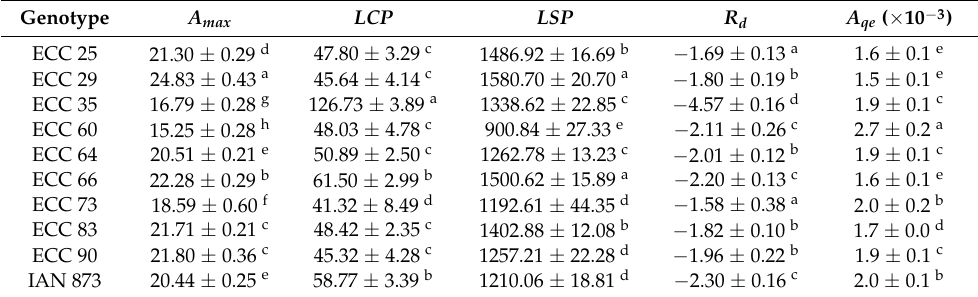
Table 1. Traits derived from the photosynthetic light-response curves ( A/PAR ) in nine Hevea brasiliensis genotypes from the ECC-1 ( É lite Caquet á Colombia) selection and the cultivar IAN 873 (control) in Caquet á (Northwestern Colombian Amazon). Maximum net CO 2 assimilation rate ( A max ) ( µ